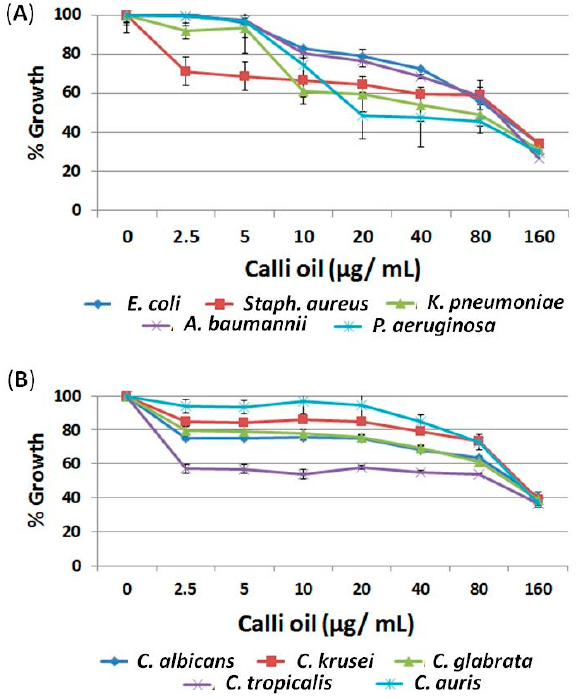
Figure 2. Antibacterial and anti- Candida effects of Calli oil isolated from Calligonum comosum grows in the UAE. The effect of different Calli oil concentrations on ( A ) Gram-negative and Gram-positive bacteria and ( B ) different Candida spp. Calli oil at 160 µg/mL caused significant inhibition of the growth of all tested bacterial spp. and Candida strains down to ca. >60%. The data display the mean of the percentage of microbial growth at different concentrations ± standard error of the mean.